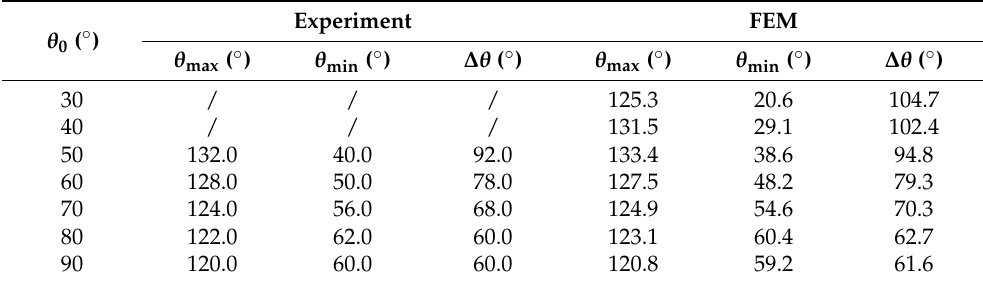
Table 4. Comparison of the experimental and numerical results in critical wrinkling